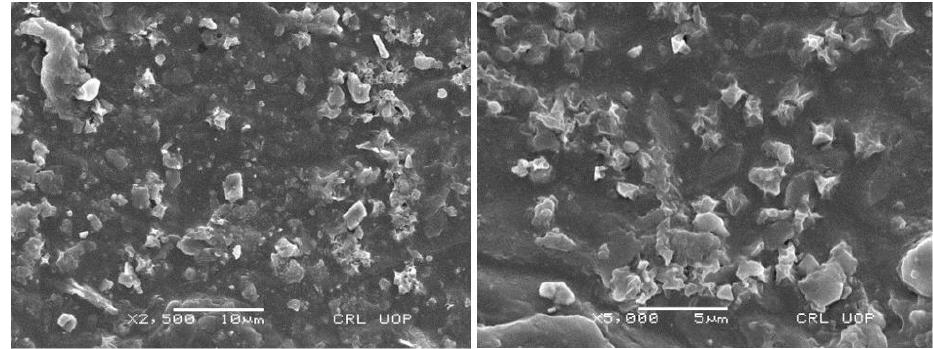
Figure 4. Surface morphology of PEGAAM formulation at different magnifications.